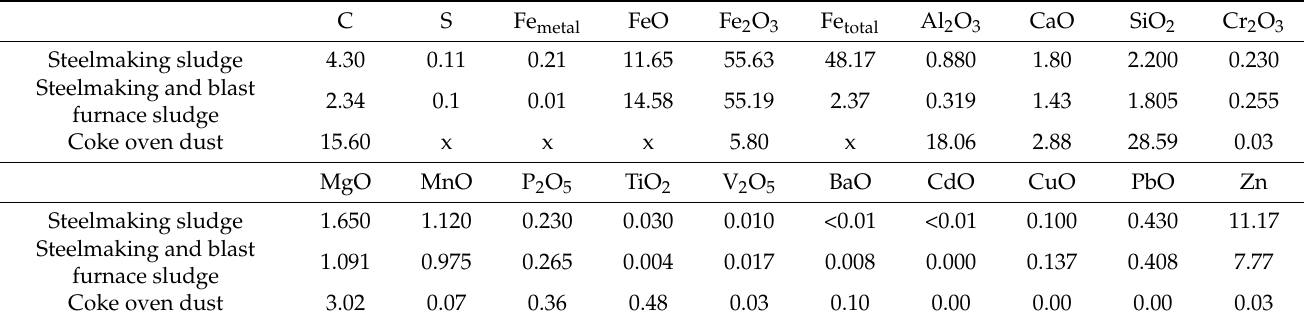
Table 3. The chemical composition of the steelmaking sludge and mixtures of steelmaking and blast furnace sludge and coke oven dust [wt.%] obtained from XRFS analysis.